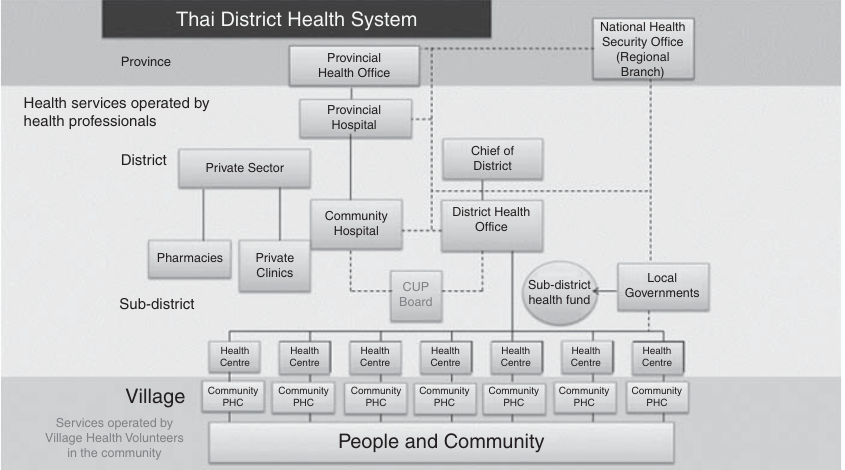
Figure 4. Thai district health